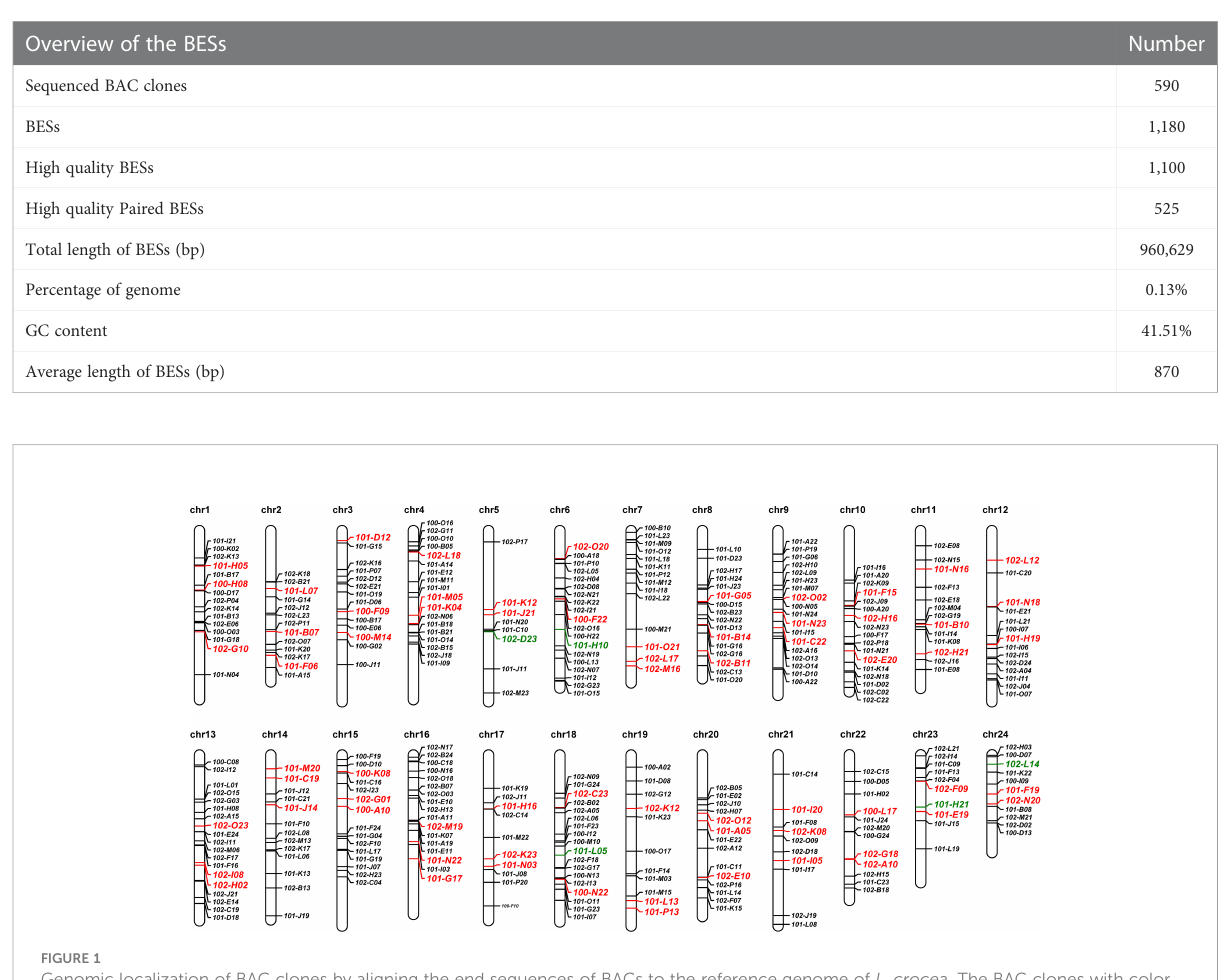
TABLE 1 Overview of the BAC end sequences (BESs) of L. crocea .